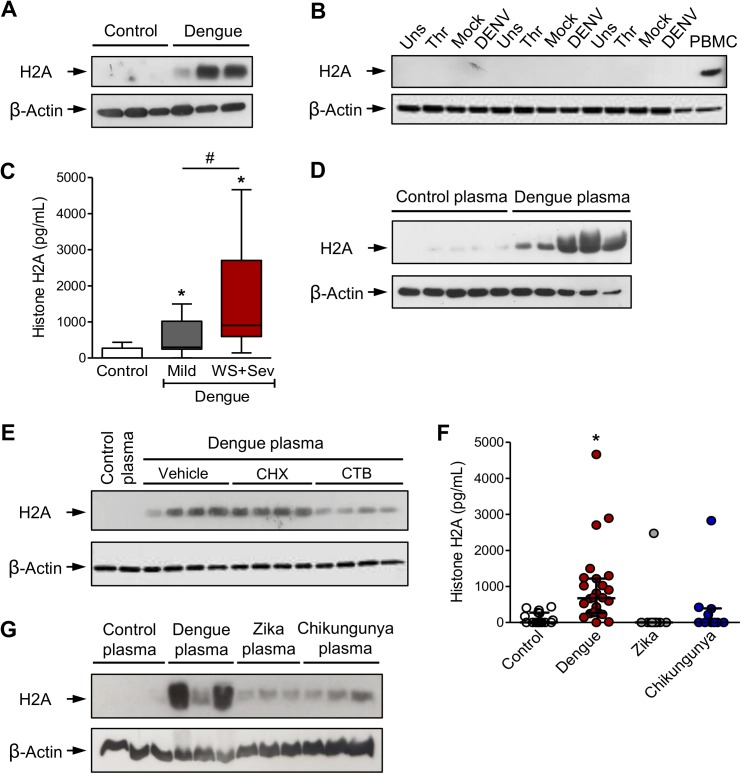
Platelets sequester circulating histone H2A in plasma from dengue-infected patients.(A-B) Western blot analysis for histone H2A and β-actin in (A) freshly isolated platelets from three healthy volunteers (Control) and three patients with dengue; and in (B) platelets from three healthy volunteers that were kept unstimulated (Unst) or stimulated with thrombin (Thr), DENV or Mock for 6h. Human peripheral blood mononuclear cells (PBMC) were used as positive control for histone H2A expression. (C) Histone H2A concentration in plasma from control subjects or patients with mild dengue or dengue with warning signs and severe dengue (WS+Sev). Boxes indicate the median and interquartile ranges and whiskers indicate minimal and maximal values in each group. (D-E) Platelets were isolated from a healthy volunteer and incubated with 20% plasma from five dengue-infected patients (dengue plasma) or five healthy volunteers (control plasma) for 4 hours in the presence or absence of cyclohexamide (CHX), cytochalasin B (CTB) or DMSO (vehicle). (F) Histone H2A concentration in plasma from control subjects or patients with dengue, zika or chikungunya fever. Each dot represents the level of histone H2A in plasma from one patient or control. Lines represent median and interquartile range. (G) Western blot analysis for histone H2A and β-actin in platelets incubated with 20% plasma from three control subjects or three patients with dengue, zika or chikungunya. * means p<0.05 compared to control, zika or chikungunya; # indicates p<0.05 between patients with mild and WS+Sev dengue syndromes. Western blots (D, E and G) are representative of three independent experiments from individual platelet donors.